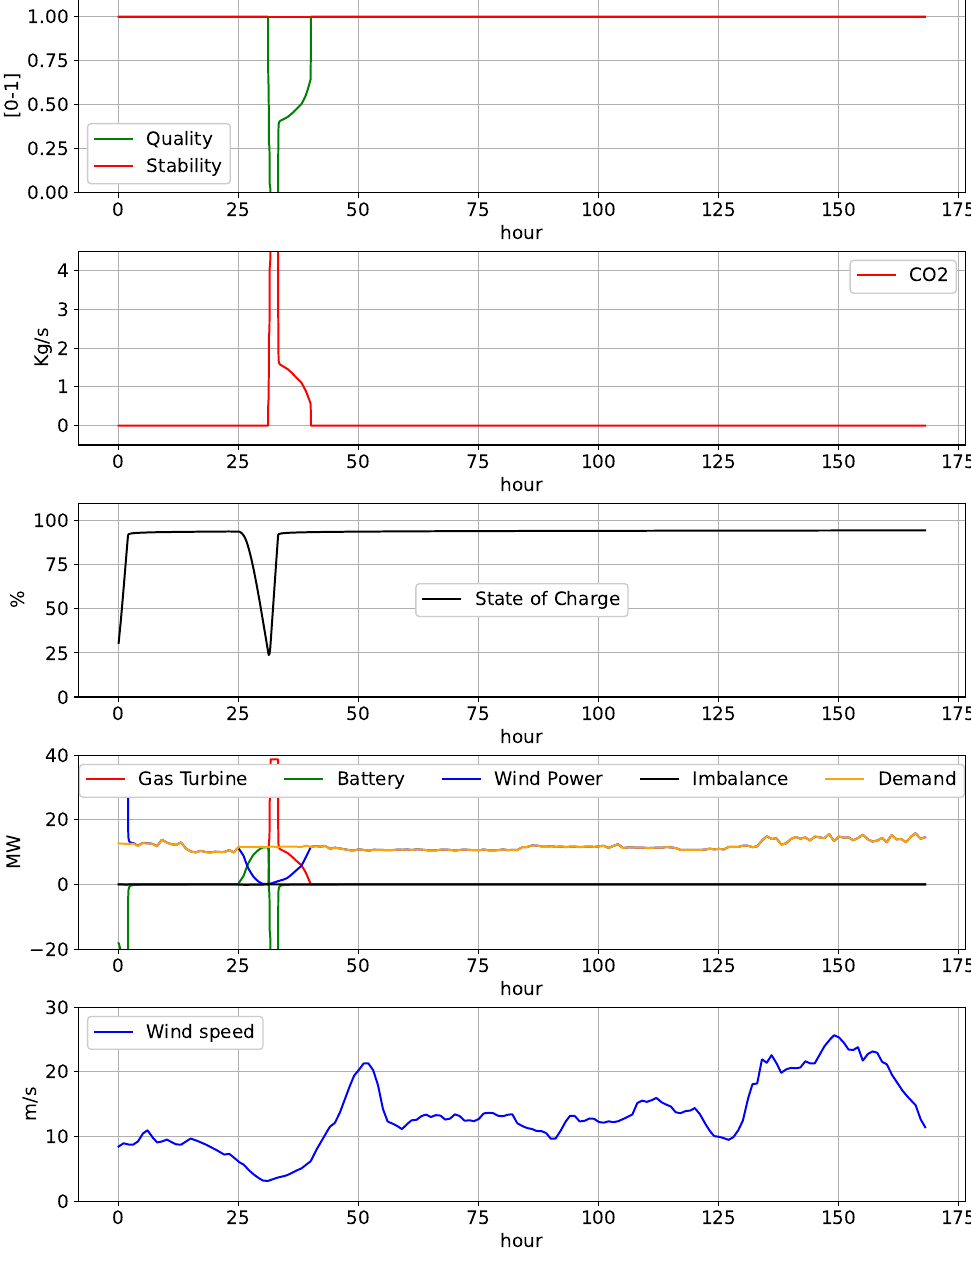
Figure 17. Strategy 4 with high wind speed